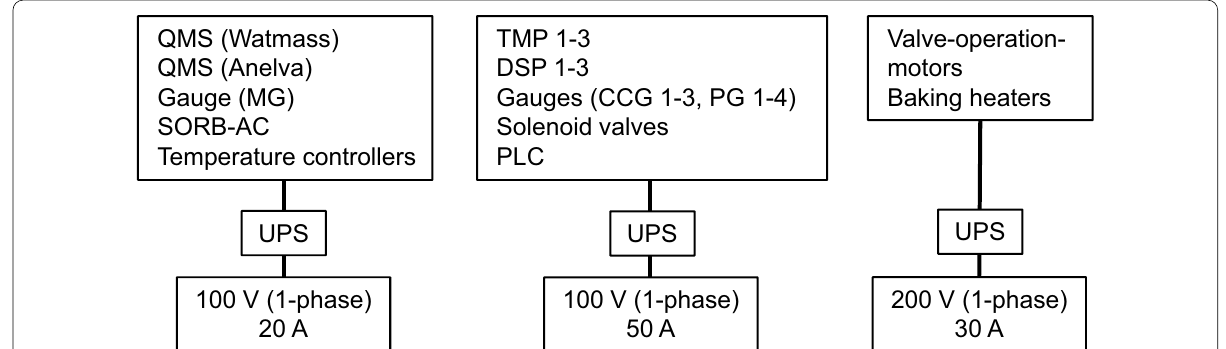
Fig. 6 Schematic diagram of power source distribution. The PLC performs valve operation and system status